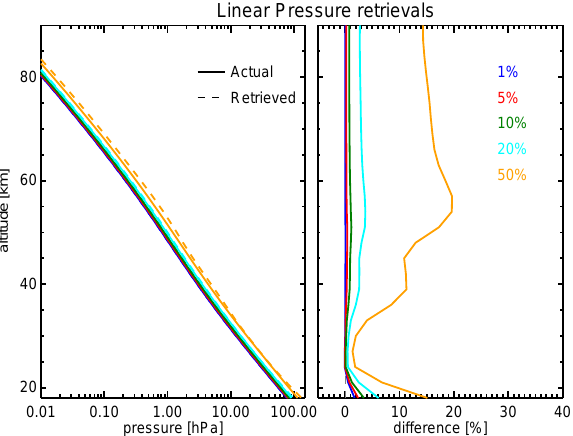
Table 1. MIPAS spectral bands.